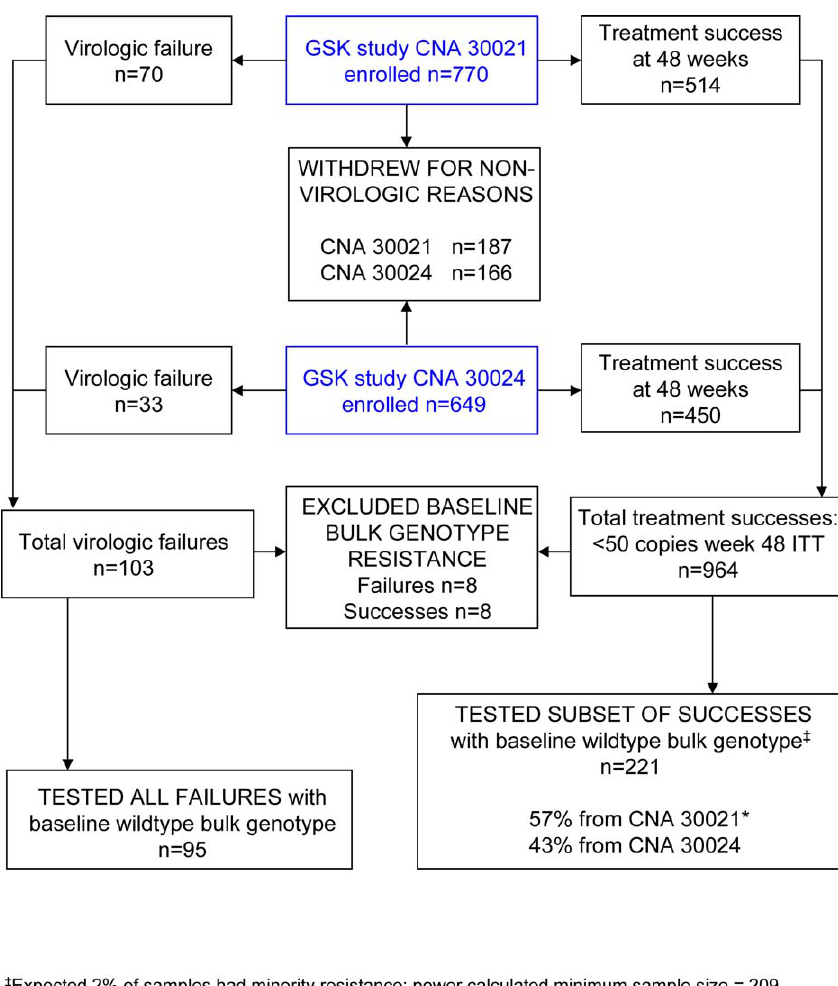
Figure 2. STROBE-Type Flow Diagram for the Retrospective Case-Control Treatment Study Illustrating the Parent Cohort (Blue) Outcomes and Sample Selection for Real-Time PCR Resistance Testing